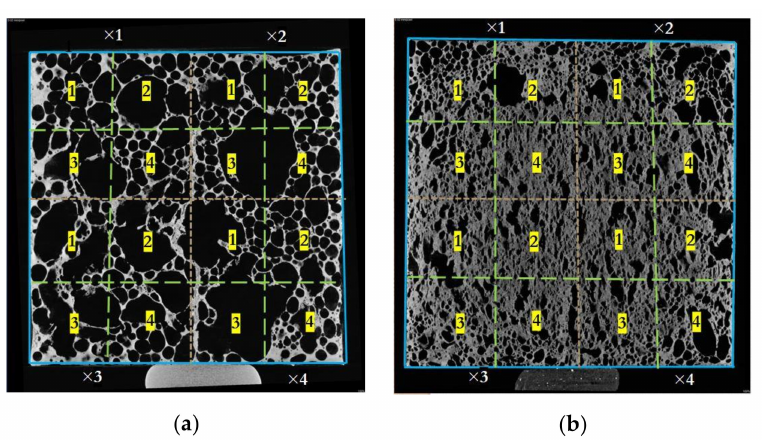
Figure 4. 16 split sections are represented with the dotted line of the sample A1 ( a ) and A2 ( b ). The X-ray slice images are cropped according to these split sections, and the 3D model is